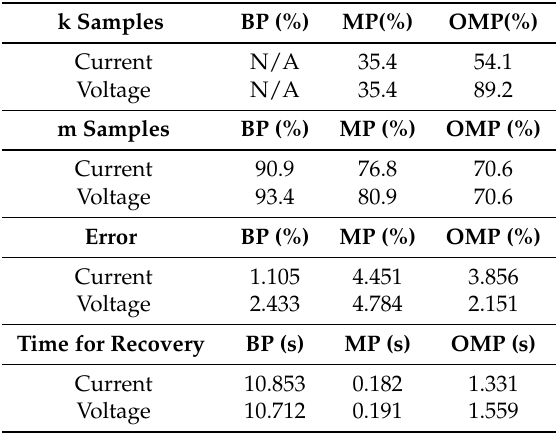
Table 1. Results of signal reconstruction techniques. k